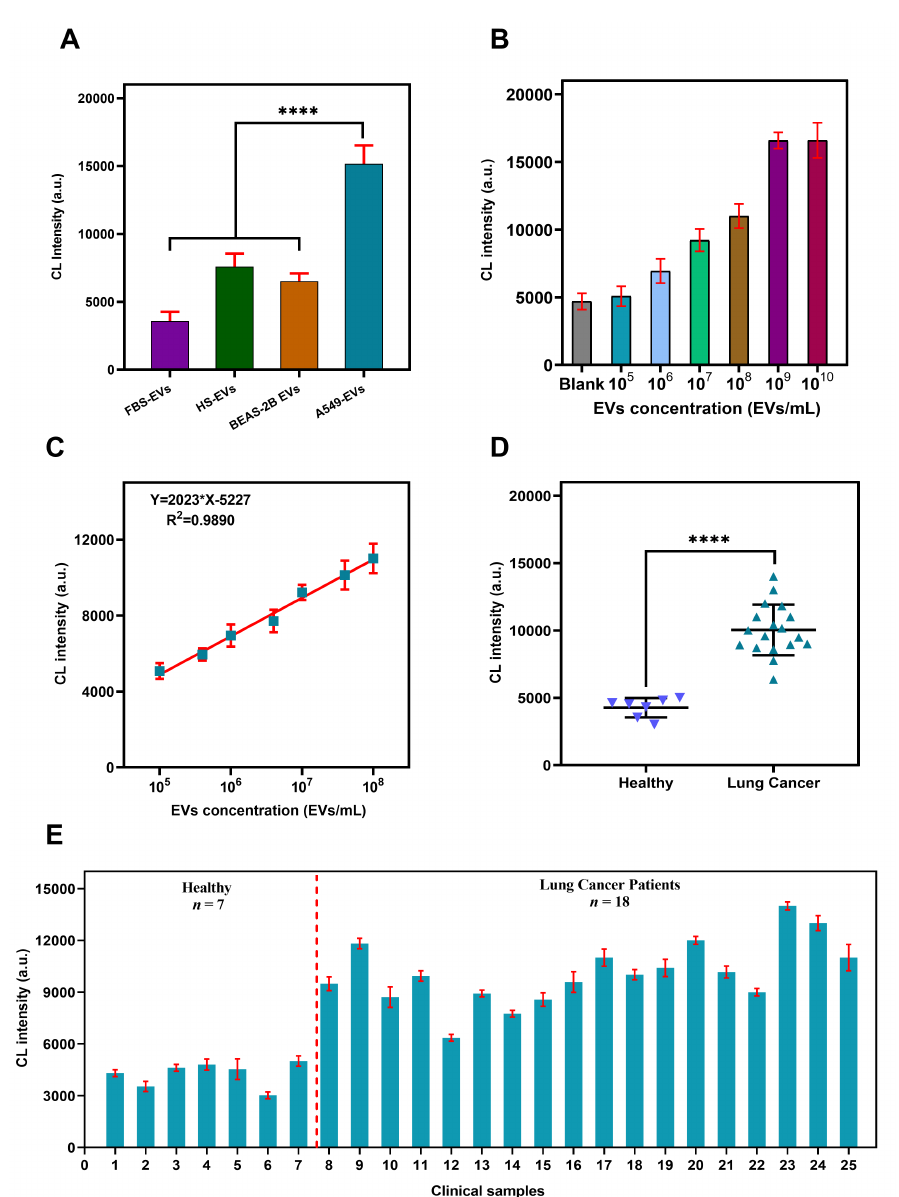
Figure 5. Assay features validation. ( A ) Assay specificity for PDL@EVs. HS (healthy serum) FBS (Fetal bovine serum). ( B ) Assay performance on different concentration of EVs. ( C ) Assay’s linear fitting between CL intensity and concentration of EVs. ( D , E ) Assay performance validation using clinical serum samples. (Error bar indicates standard deviation of three replicates, **** = p ≤